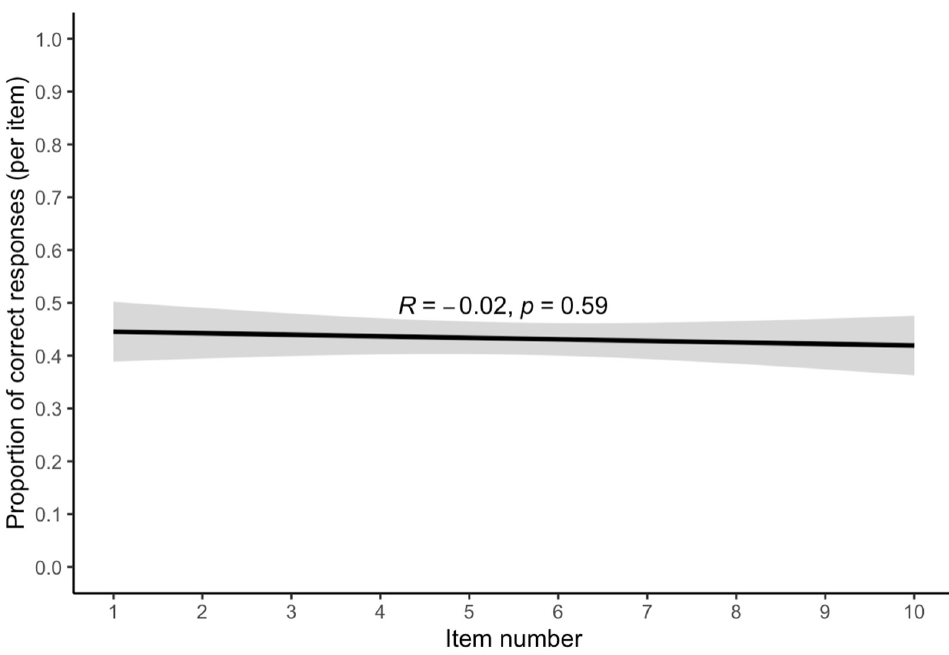
Figure A2. Practice effect test in Study 2 (N = 102). Performance did not increase or decrease during the survey. Error bands indicate standard